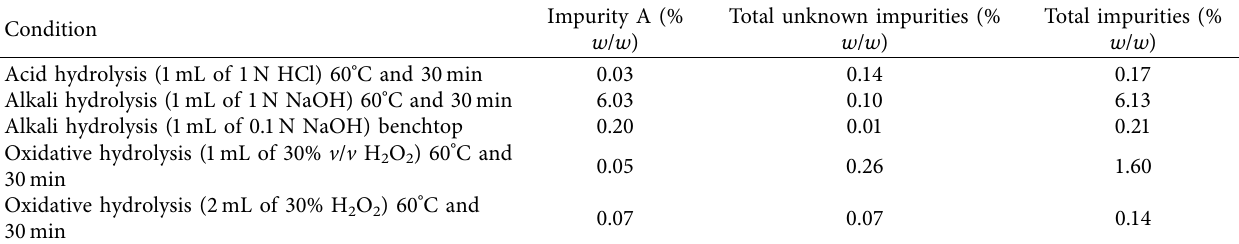
Figure 4: Chromatogram of neostigmine methylsulfate injection (0.5mg/mL). Table 3: Forced degradation data of neostigmine methylsulfate API.